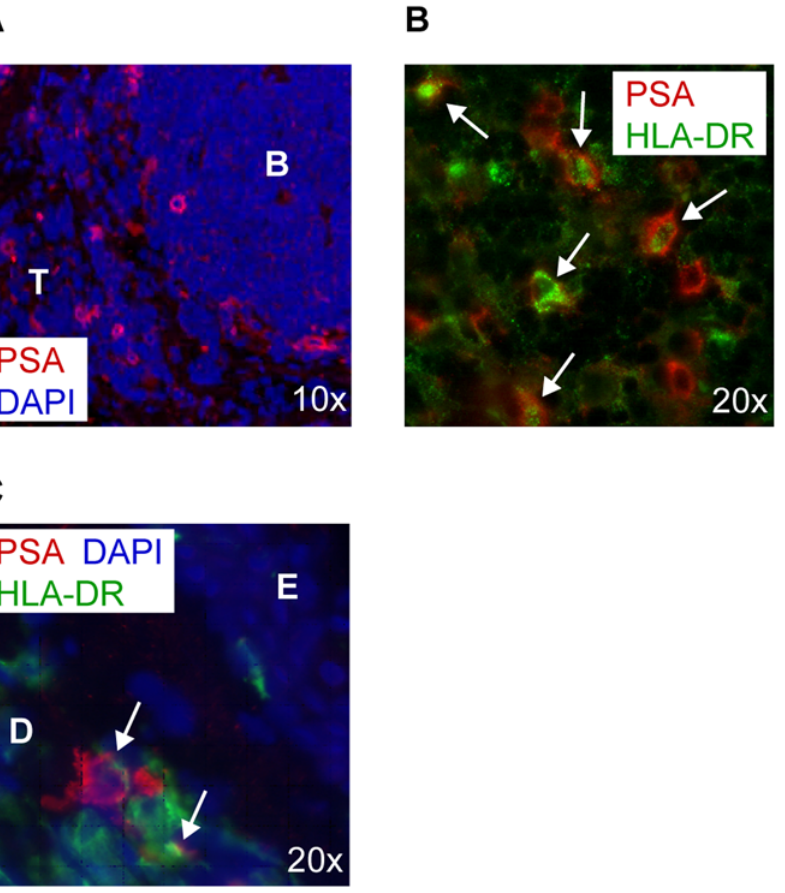
Figure 4. PolySia + antigen presenting cells are present in human tissue. (A) Tissue biopsies of human lymph node were stained with moAb 735 (red). PolySia positive cells in the lymph node are located in the T cell area ( T ) but not in the B cell follicle ( B ). Nuclei are visualized in blue (10 6 ). (B) Human lymph node was double stained using moAb 735 (red) and anti-HLA-DR (green). Arrows indicate double positive cells. Nuclei are visualized in blue (20 6 ). (C) Tissue biopsies of human skin were double stained with moAb 735 (red) and anti-HLA-DR (green). Only deep in the dermis ( D ) and not in the epidermis ( E ) polySia + cells can be detected. Arrows indicate double positive cells. Nuclei are visualized in blue (20 6 ).